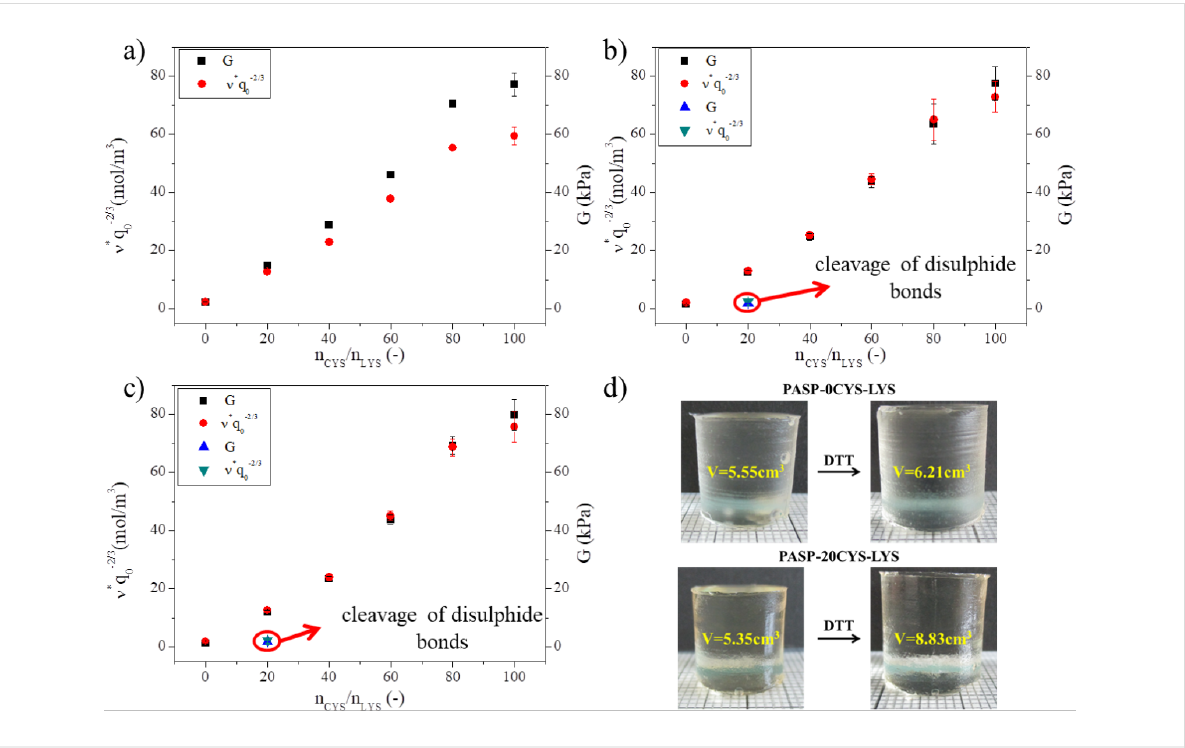
Figure 5: Dependence of the elastic modulus G (black squares, blue triangles) and the concentration of the elastically active chains v *q 0 − 2/3 (red dots, green triangles) on the CYS/LYS molar ratio in a) DMSO, b) imidazole buffer (pH 8, c = 0.1 M, I = 0.25 M) and c) PBS (pH 7.4, I = 0.15 M). d) Gel cylinders before and after DTT